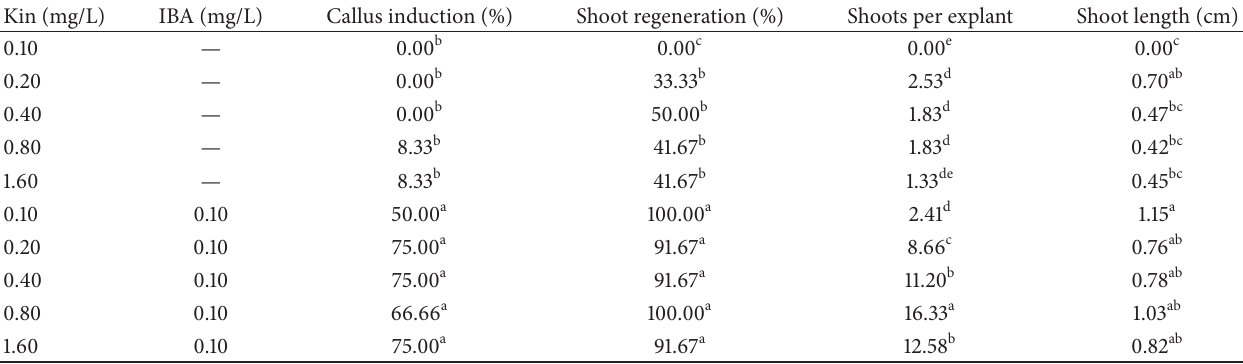
Table 1: Effects of different Kin-IBA concentrations on shoot regeneration of H. polysperma from leaf explant .